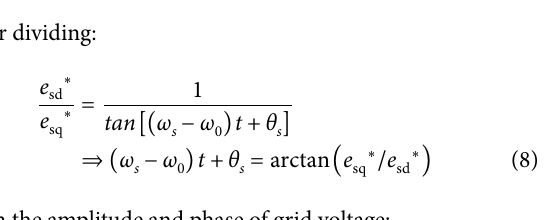
FIGURE 6 | The detection results in steady state environment.